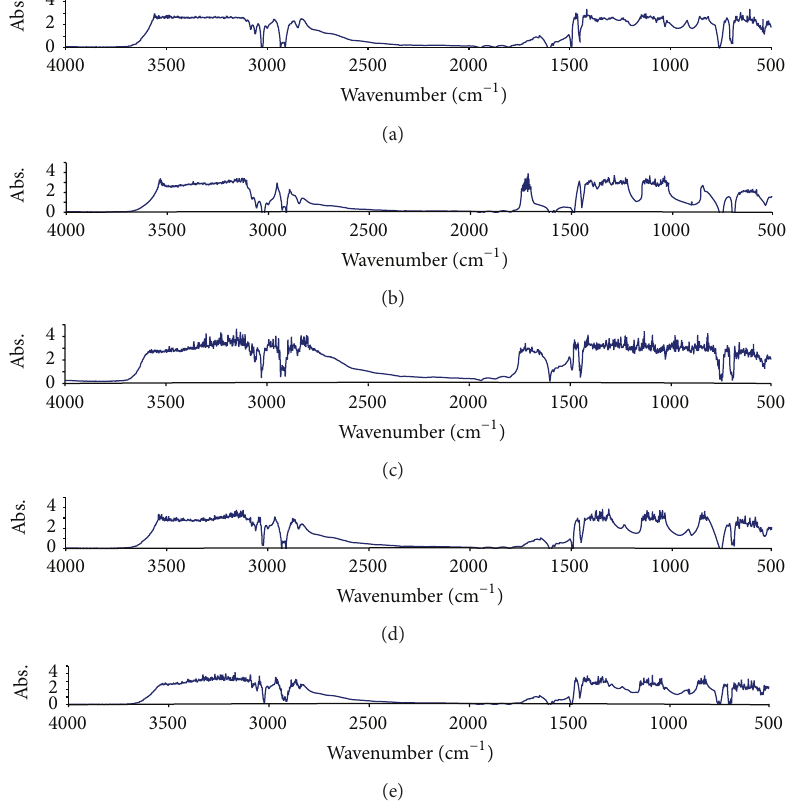
Figure 3: (a–e) Absorption spectra of pure PVA obtained from FTIR for PVA doped with ErCl 3 of concentrations 1, 3, 5, 7, or 9wt%,